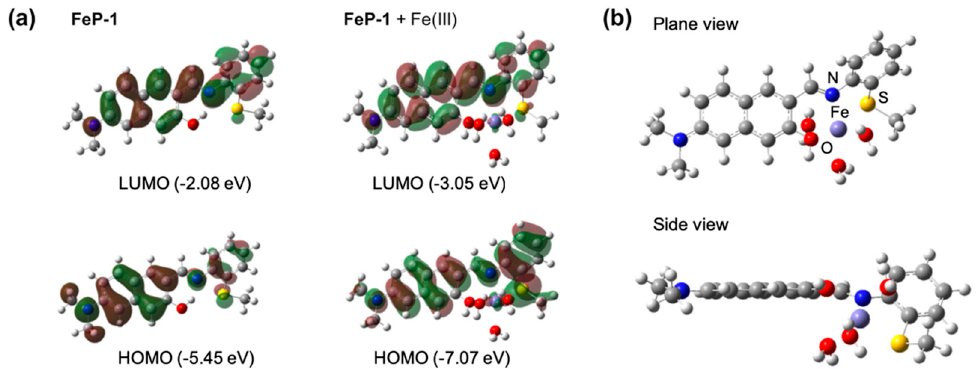
Figure 2. ( a ) The optimized molecular structures and HOMO / LUMO, and energy levels of FeP-1 , FeP-1 + Fe(III) complex by DFT calculations (APFD / 6-31 + G(d,p)). ( b ) Plane / side view of FeP-1 + Fe(III) complex. Fe(III) complex contains three additional water molecules in DFT calculations.